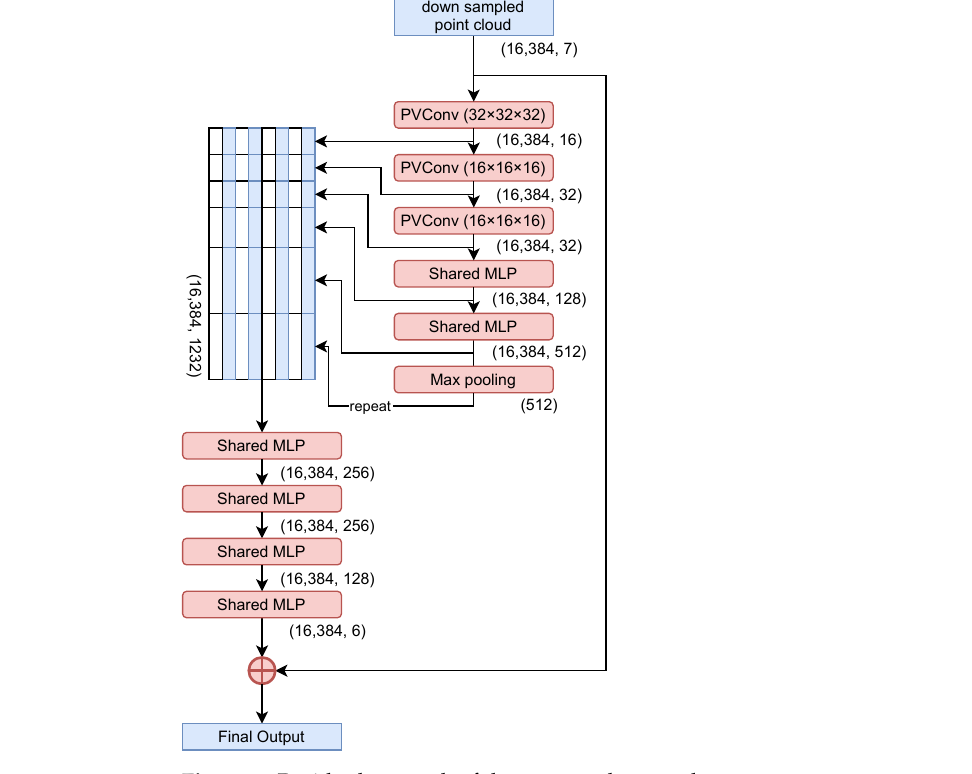
Figure 5. Residual network of the proposed network.